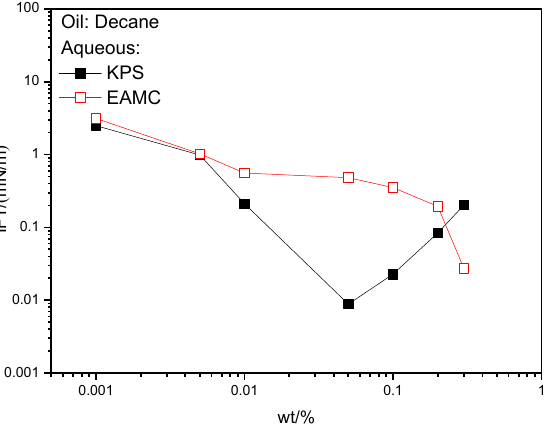
Figure 1. The dynamic IFTs of KPS ( a ) and EAMC ( b ) solutions against decane.